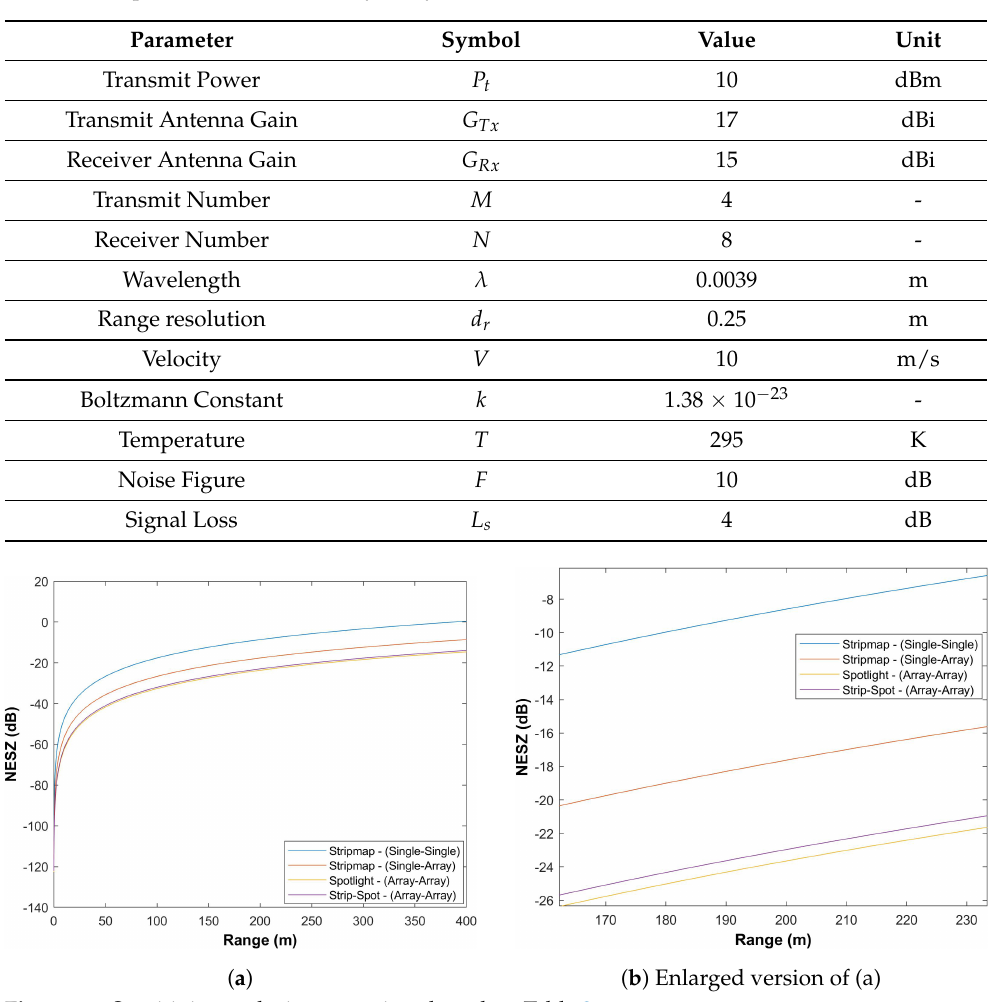
Table 4. The parameters of sensitivity analysis.